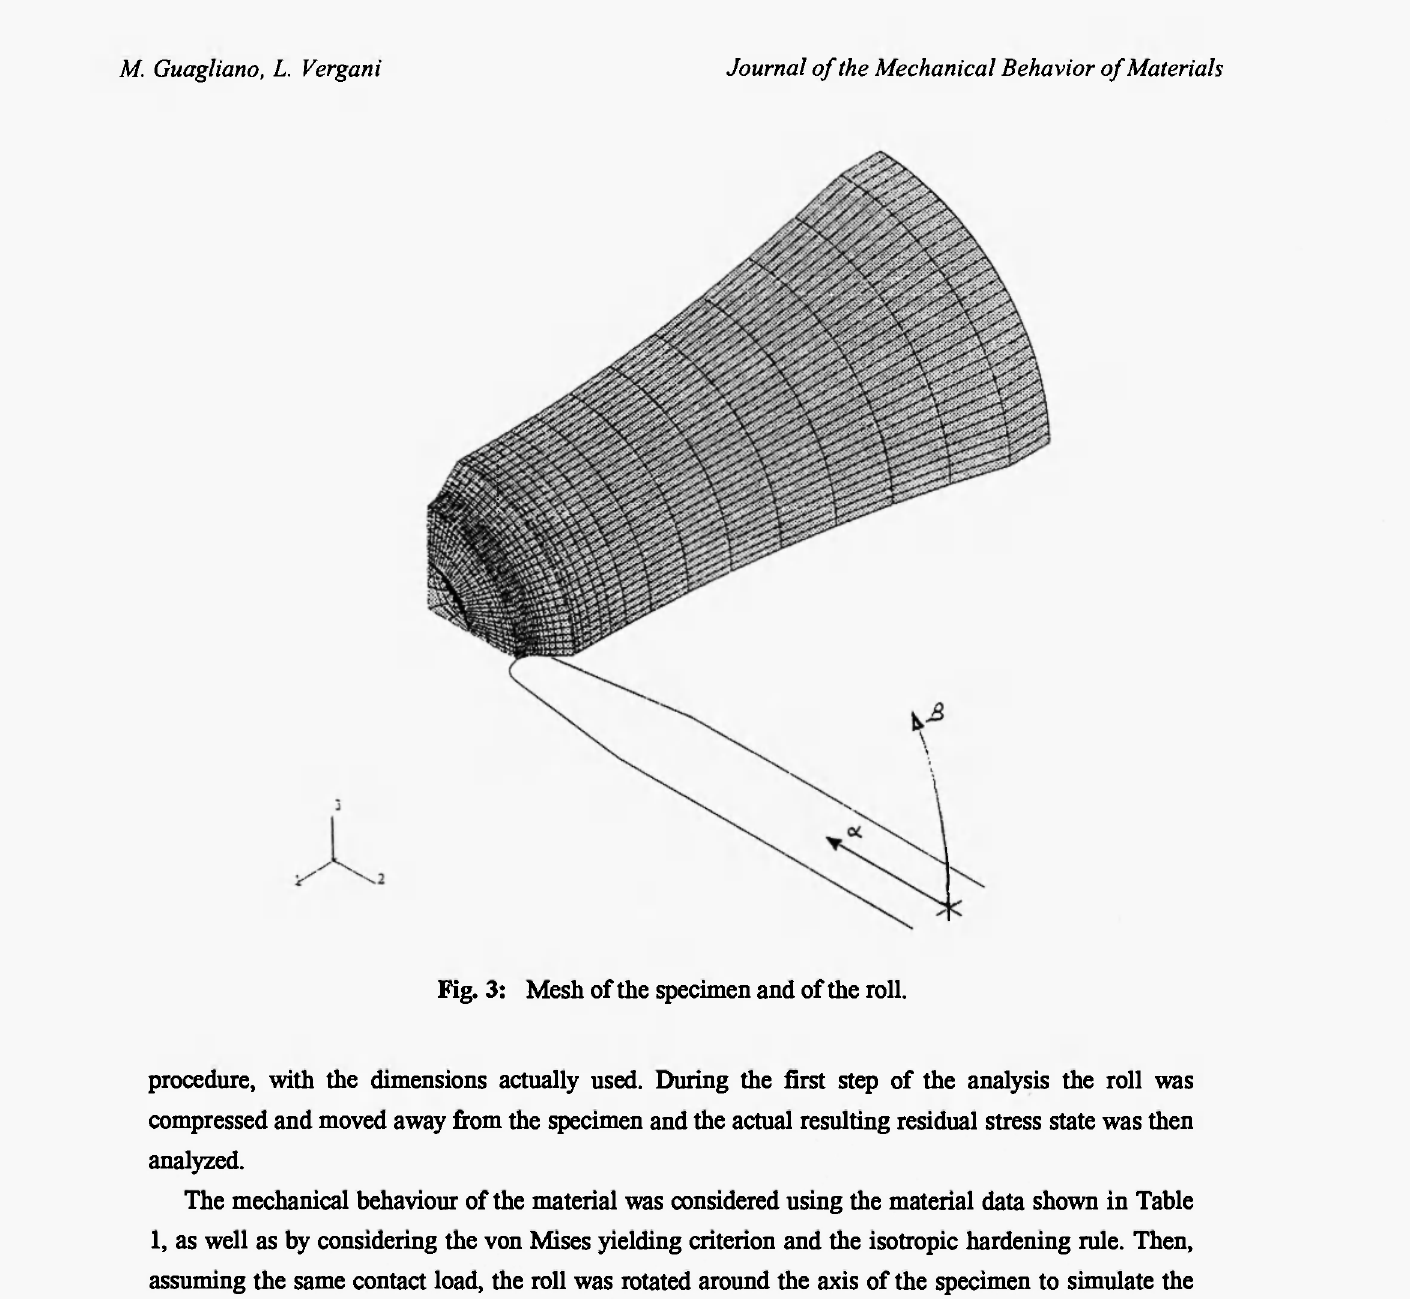
Fig. 3: Mesh of the specimen and of the